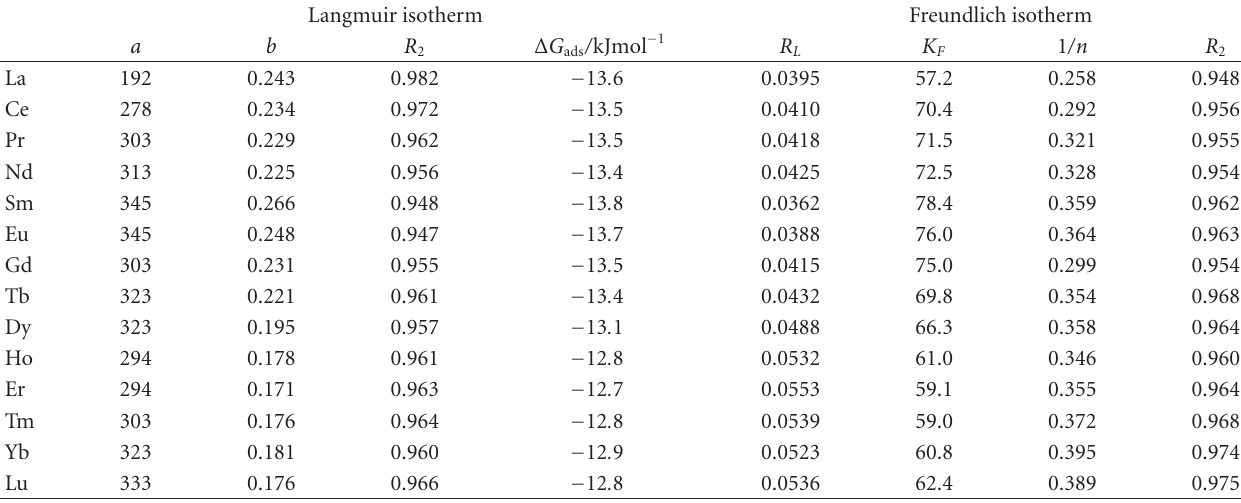
Table 4: Coe ffi cient of Langmuir and Freundlich isotherms for lanthanides using Buccinum tenuissimum shell biomass after heat treatment (480 ◦ C , 6 hours).